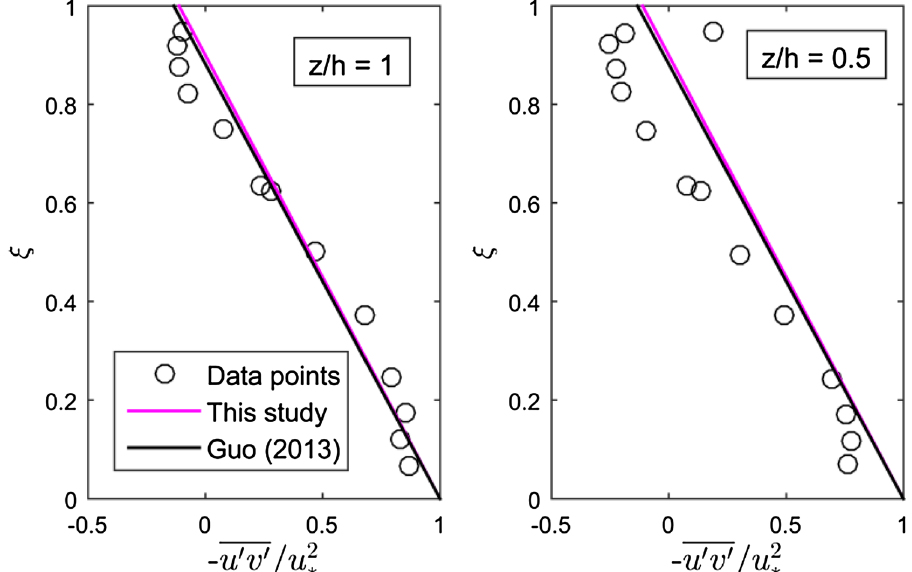
Fig. 5 Prediction of total shear stress by Eqs. (10) and (11) using